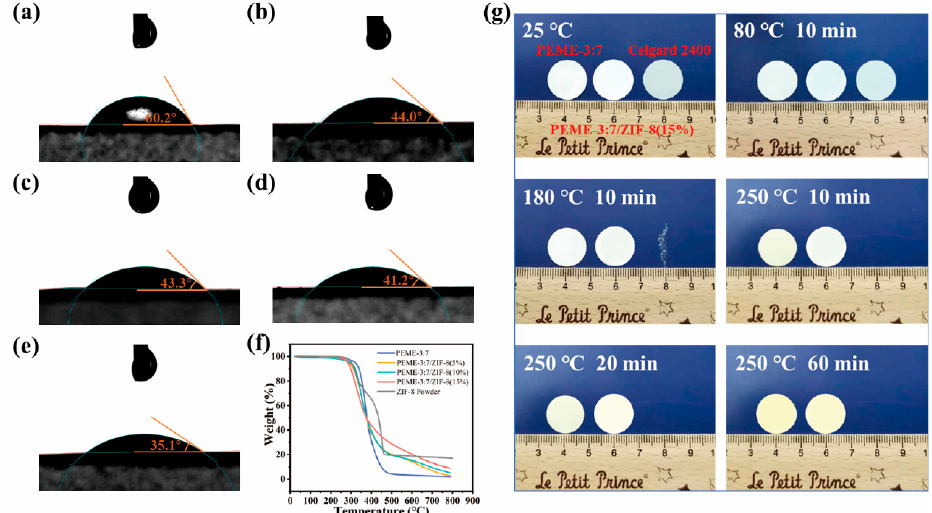
Figure 4. Surface contact angles of ( a ) Celgard 2400; ( b ) PEME-3:7; ( c ) PEME-3:7/ZIF-8(5%); ( d ) PEME-3:7/ZIF-8(10%), and ( e ) PEME-3:7/ZIF-8(15%) with 1 M LiPF 6 /EC: DME (1:1, v / v ); ( f ) TGA test curves of different components, and ( g ) Schematic changes in appearance of Celgard 2400, PEME-3:7, and PEME-3:7/ZIF-8(15%) membranes with temperature and time.